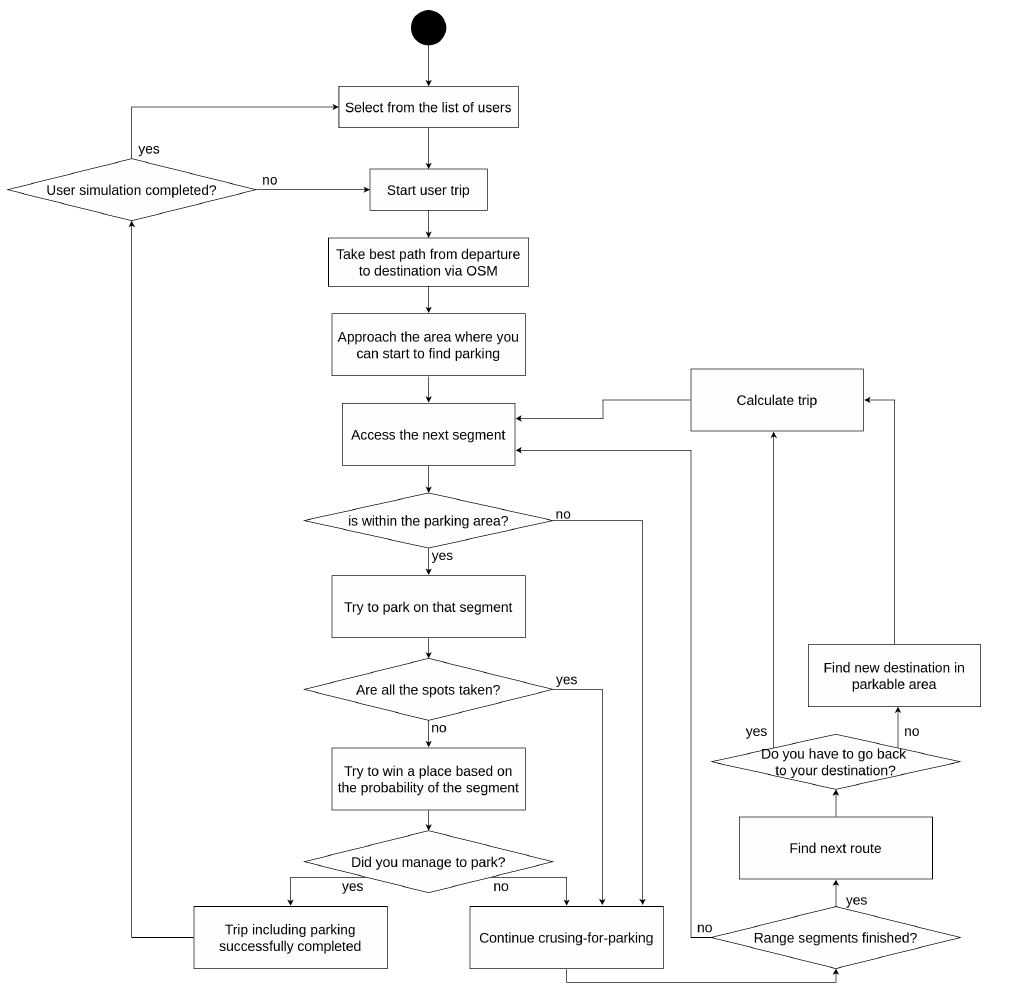
Figure 1. Trip simulation flow diagram.